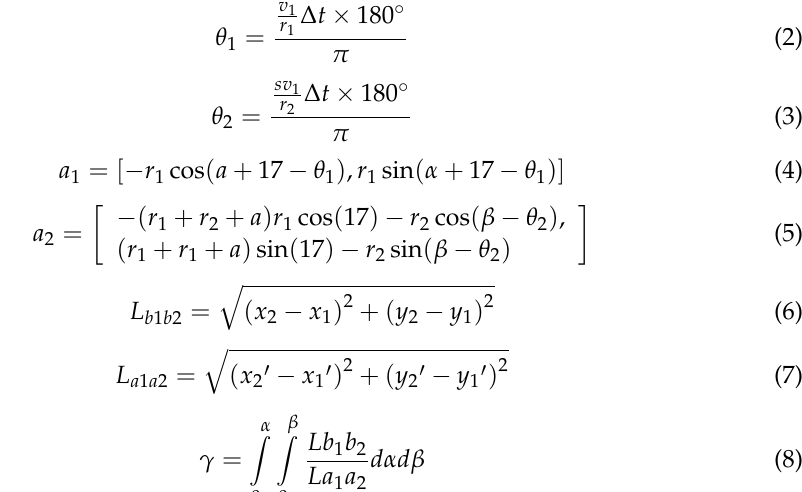
roller and the spindle. In this study, the compression ratio γ was used to characterize the and auxiliary roll contact point was set as b 1 ( x 1 , y 1 ), b 2 ( x 2 , y 2 ), and its length was L b 1 b 2